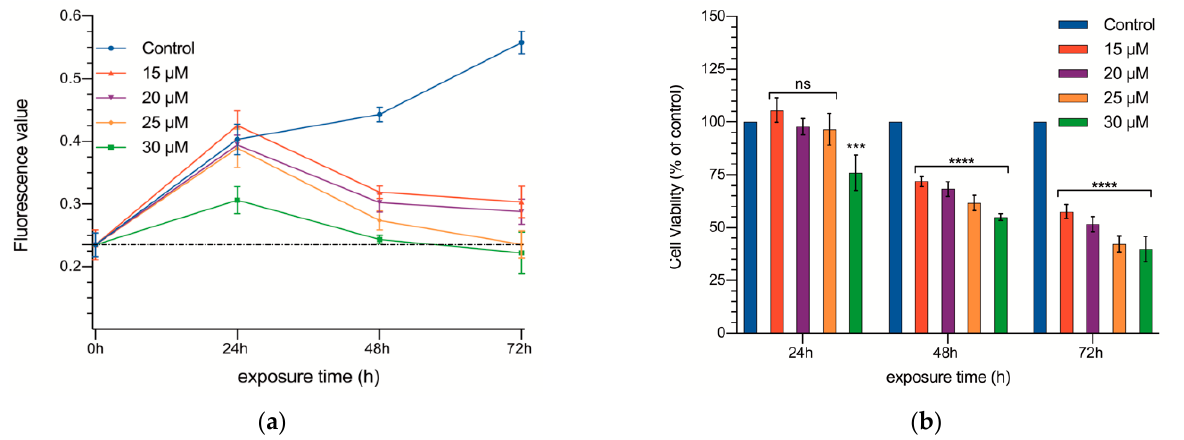
Figure 1. Cell proliferation of CC531 rat colorectal cancer cells as a function of time. Absolute fluorescence values ( a ) and percentage of control ( b ) and cultures supplemented with 15, 20, 25, and 30 µM of curcumin at 24, 48, and 72 h. The dotted line of the figure a shows fluorescence values prior to curcumin exposure. Results are expressed as mean and standard deviation (SD) from three replicates (16 well per replicate), and have been statistically analyzed by a one-way ANOVA test, followed by Newman − Keuls multiple comparison test for between-group comparisons. Asterisks indicate statistical significance: ***: p < 0.001; **** p < 0.0001; ns: p > 0.05.